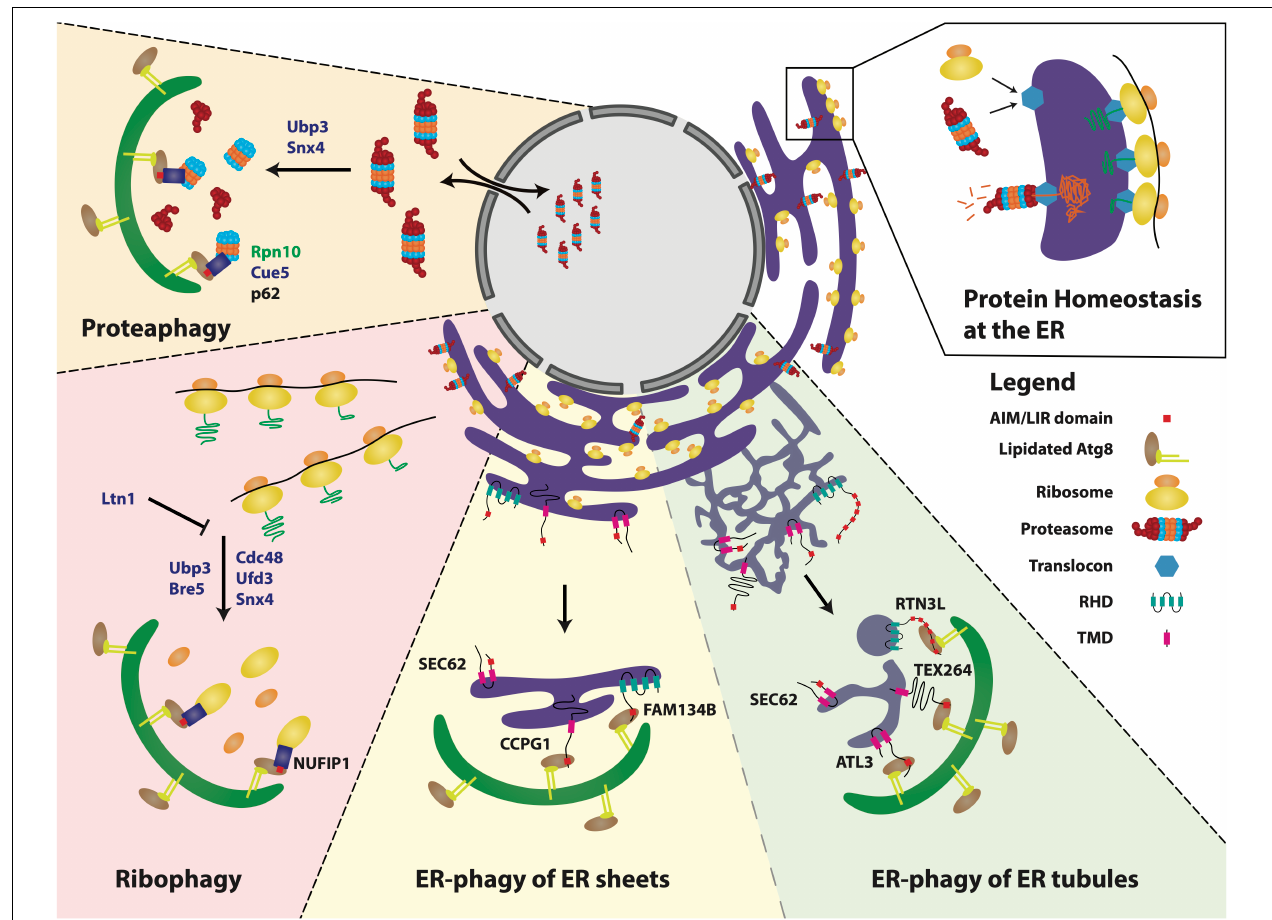
FIGURE 1 | Selective autophagy of the protein homeostasis machinery. Ribosomes, proteasomes and the ER monitor and maintain protein homeostasis to ensure cellular functionality. These machineries are themselves targeted by selective autophagy as a means to regulate balanced cellular homeostasis and functionality. Proteasomes are degraded through the process of proteaphagy in response to starvation and/or proteasome inhibition. This process is conserved from yeast to mammals, yet with several mechanistic differences. In yeast, Ubp3 and Snx4 play key roles in triggering proteasome degradation. Identified proteaphagy receptors include Rpn10 in plants, Cue5 in yeast and p62 in mammals. Ribophagy of the small and large ribosomal subunits is induced by different stress conditions in yeast and mammals, including starvation/mTORC1 inhibition. In yeast, ribosome de-ubiquitination by the Ubp3 complex (comprising Ubp3, Bre5, Cdc48, and Ufd3) leads to degradation of the large subunit, which is antagonized by Ltn1-mediated ubiquitination. In humans, the ribophagy receptor NUFIP1 links ribosomes to the autophagosome to direct their degradation. FAM134B, RTN3L, SEC62, CCPG1, ATL3 and TEX264 have been identified as mammalian ER-phagy receptors. FAM134B and CCPG1 are implicated in ER maintenance of polarized cells, such as sensory axons and pancreatic acinar cells and are preferentially involved in ER-phagy of ER sheets . TEX264, RTN3L and ATL3 have been attributed roles in ER-phagy of ER tubules . TEX264 induces ER membrane engulfment from ER tubule three-way junctions by promoting autophagosome growth from these sites. RTN3L induces tubule fragmentation, leading to subsequent engulfment and degradation. SEC62 is essential for ER recovery after stress conditions with no clear preference to either ER sheets or tubules. ER sub-domain receptor preferences still require further experimental evidence, hence the division between the two is depicted by a less prominent stippled line. Zoom in far right : Protein homeostasis at the ER is coordinated by ribosomes and proteasomes that interact with the translocon complex to deliver newly synthesized proteins to the ER or receive proteins for degradation, respectively. Abbreviations: Ubiquitin carboxyl-terminal hydrolase 3 (Ubp3), Sorting nexin 4 (Snx4), 26S proteasome non-ATPase regulatory subunit homolog (Rpn10), Coupling of ubiquitin to ER degradation protein 5 (Cue5), mammalian target of rapamycin complex 1 (mTORC1), Ubp3-associated